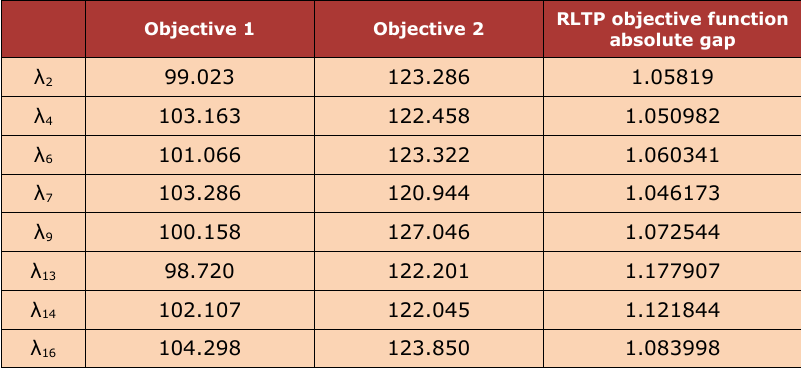
Table 17. Objective values for selected